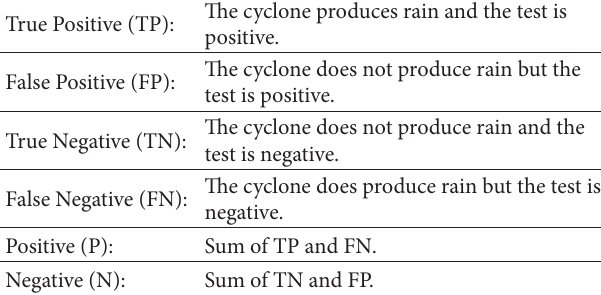
Table 2: Sensitivity, specificity, and accuracy definition terms.